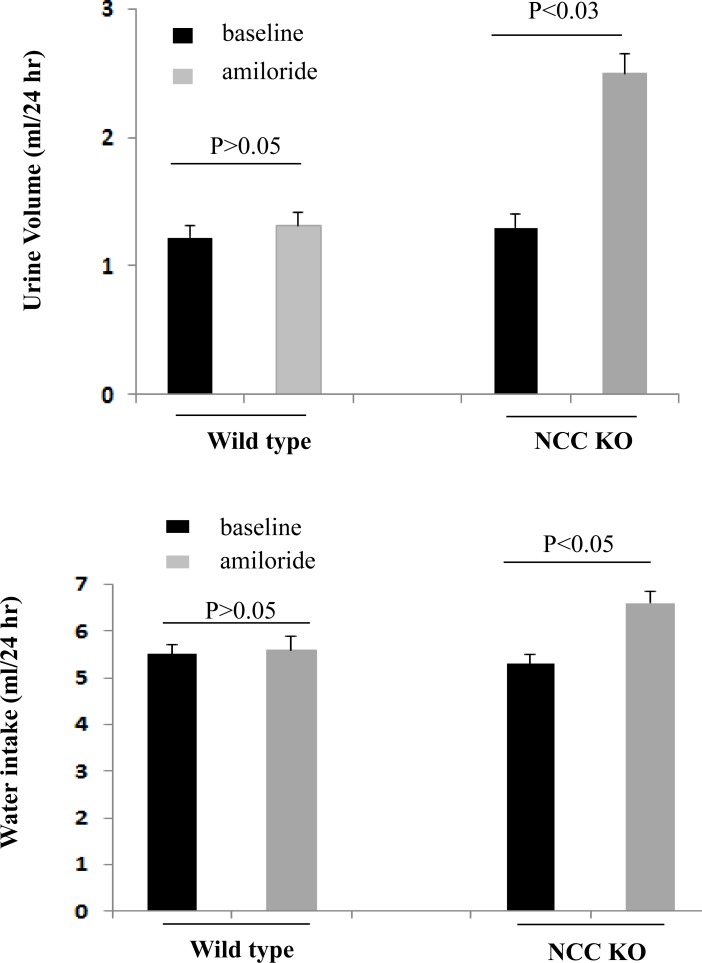
Effect of amiloride on urine output and water intake in WT and NCC KO mice.After acclimation in metabolic cages, wild type and NCC KO mice were treated with daily intraperitoneal (IP) injection of amiloride. Water intake and urine output were collected daily for 5 days. Water intake (a) and urine output (b) on day 3 and beyond were comparable.